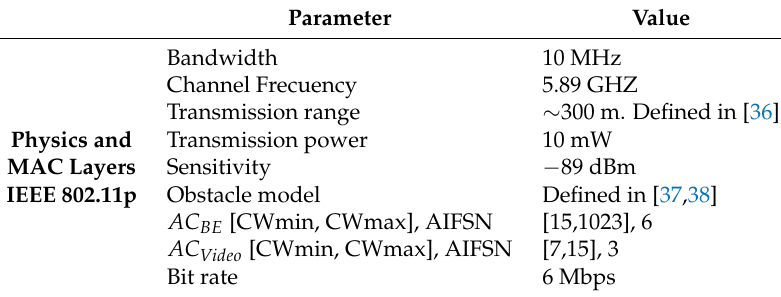
Table 4. Simulation